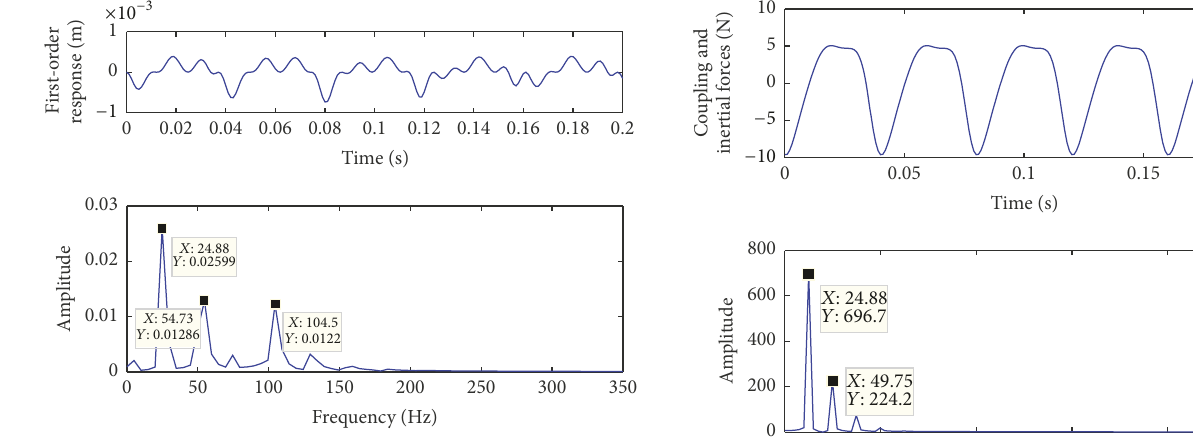
Figure 4: The first-order response and amplitude-frequency char- acteristics of the first flexible intermediate link.